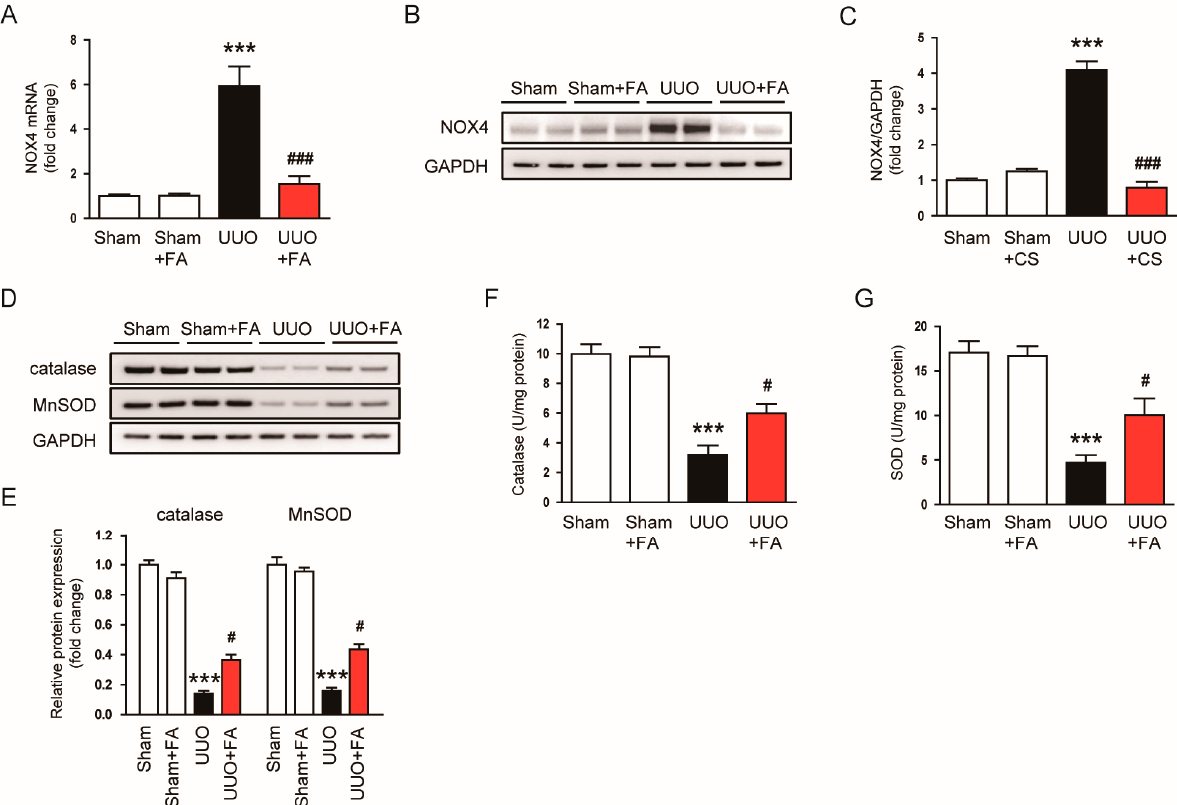
Figure 7. Effects of FA on pro-oxidant and antioxidant enzymes in UUO mice. ( A ) Renal NOX4 mRNA levels. ( B ) Western blotting of NOX4. ( C ) Quantification of Western blots for NOX4. ( D ) Western blotting of catalase and MnSOD. ( E ) Quantification of Western blots for catalase and MnSOD. ( F ) Catalase activities in kidney tissues. ( G ) SOD activities in kidney tissues. *** p < 0.001 vs. Sham. # p < 0.05 and ### p < 0.001 vs. UUO.